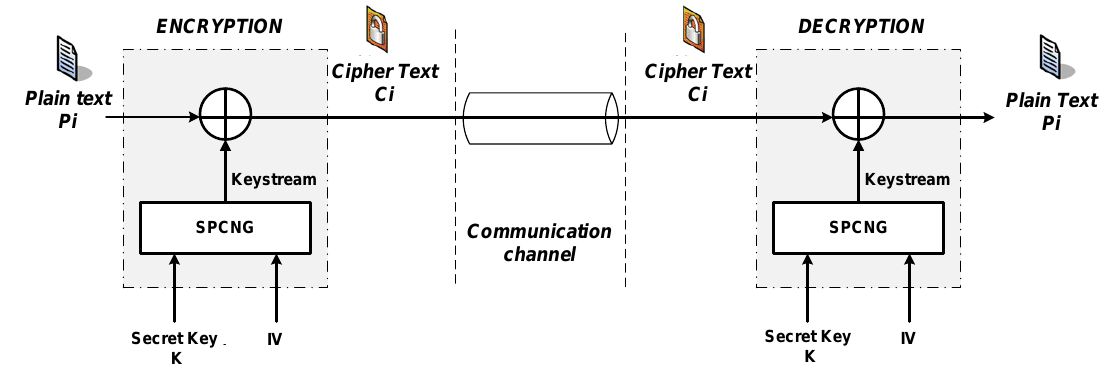
Figure 1. Block diagram of a stream encryption/decryption system.